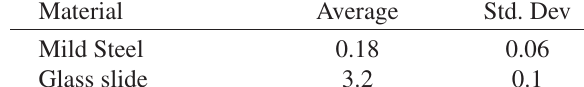
Table 2. Erosion rates of reference materials at 90° (mg/g).